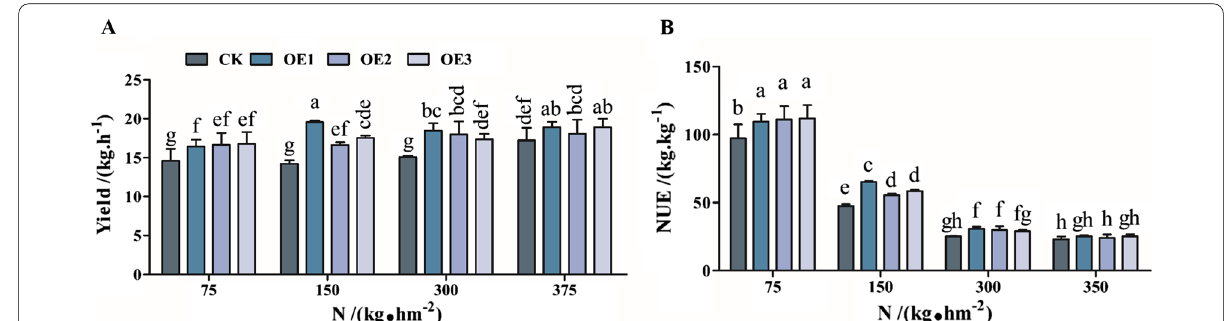
Fig. 3 AtNLP7 improved cotton yield and NUE in the field. Actual yield ( A ) and NUE ( B ) of transgenic cotton obtained under 75, 150, 300, and 375 kg hm − 2 supply of nitrogen. Results are average values · from Duncan’s multiple range